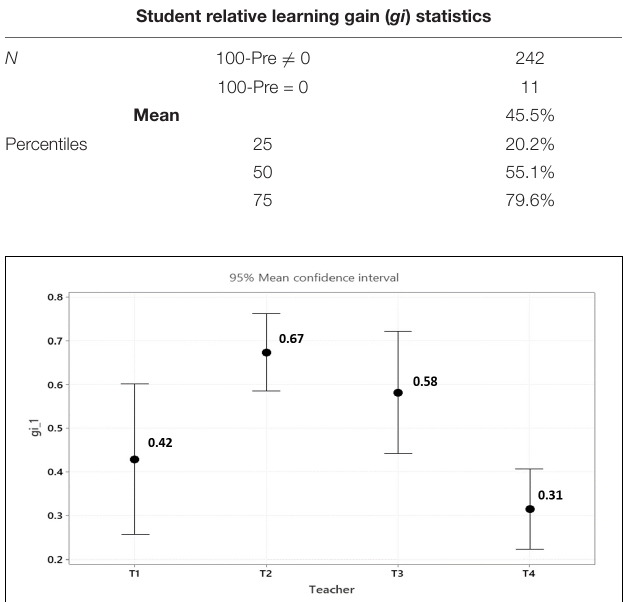
FIGURE 7 | 95% Mean confidence intervals for students relative learning gain ( gi ) first activity.